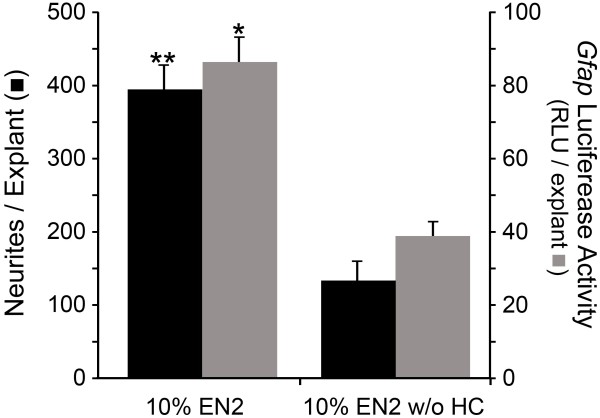
HC increased Gfap promoter activity and neurite outgrowth from retinal explants. Histograph of the mean number of neurites per explant (± SEM, black bar) and the Gfap promoter driven luciferase activity as measured by the mean relative fluorescent units (RLU) per explant (± SEM, grey bar) in transgenic PN7 retinal explants at culture day 7 treated with either 10% EN2 or 10% EN2 without HC (EN2 w/o HC). EN2 treated explants had significantly more Gfap promoter activation (*P<0.001) and neurites (**P=0.031) than EN2 w/o HC treated explants. Significance was determined by Student’s t-test, p<0.05.